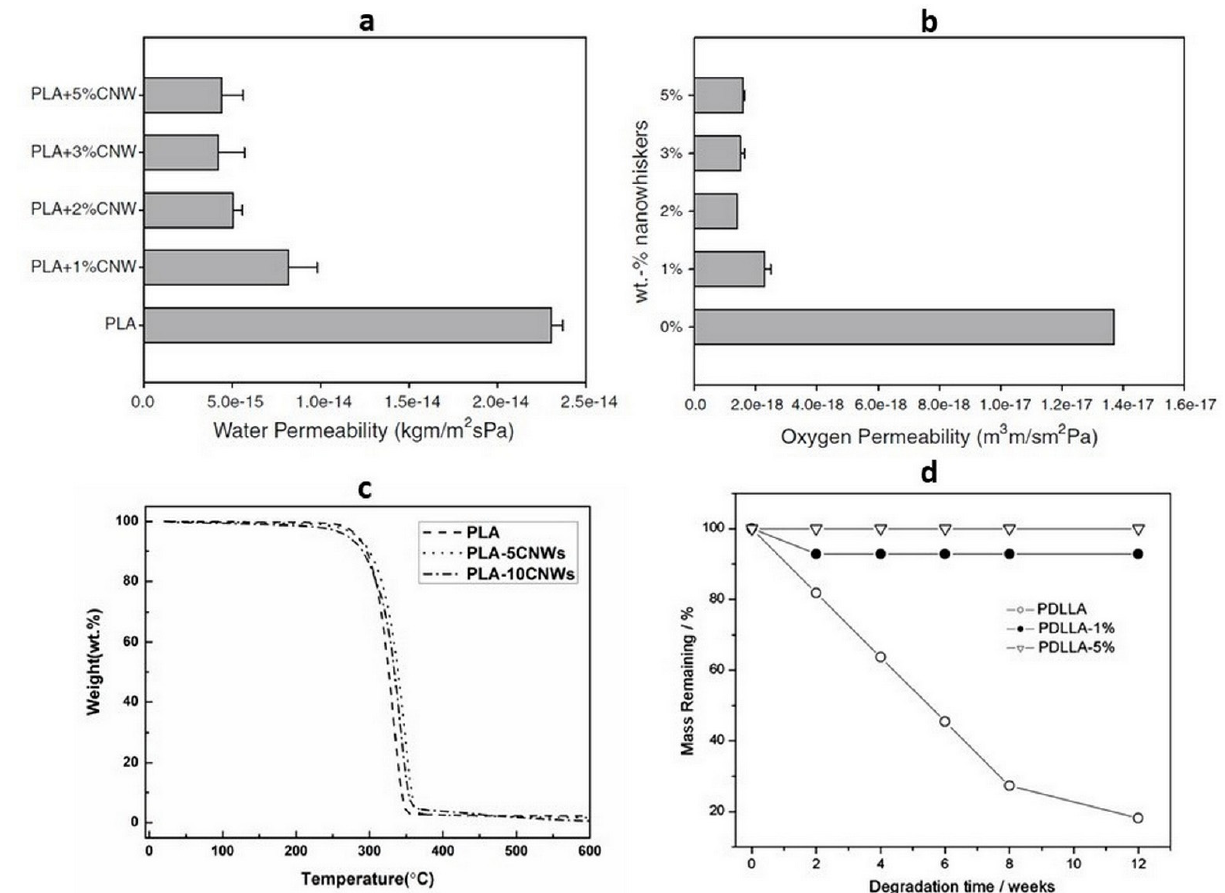
Figure 4. ( a ). Water permeability of PLA and their nanocomposites with various CNW content.; ( b ). Oxygen permeability of PLA and their nanocomposites with various CNW content. (Copyright and permission, [26]); ( c ). Thermogravimetric analysis (TGA) thermogram of the PLA and PLA–CNW; ( d ). Residual mass of the neat PDLLA and its nanocomposites as a function of degradation time. (Copyright and permission, [83]).